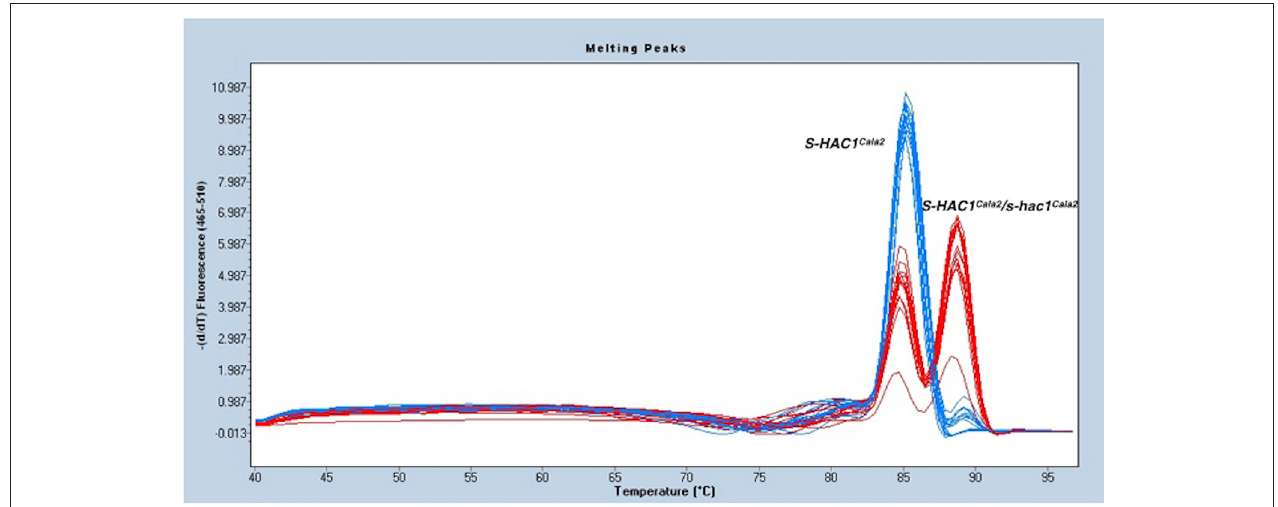
FIGURE 4 | S-HAC1 Cala2 and s-hac1 Cala2 alleles segregate in selfed Hpa- Cala2. Twenty-nine cultures derived from oospores of selfed Hpa- Cala2 were subjected to high-resolution melt curve analysis using S-HAC1 Cala2 -specific primers. Blue peaks show homozygous S-HAC1 Cala2 lines and red peaks show heterozygous lines. The experiment has been repeated with the s-hac1 Cala2 specific primers and the same results were